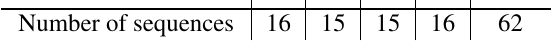
The number of gaze sequences with each task complexity.